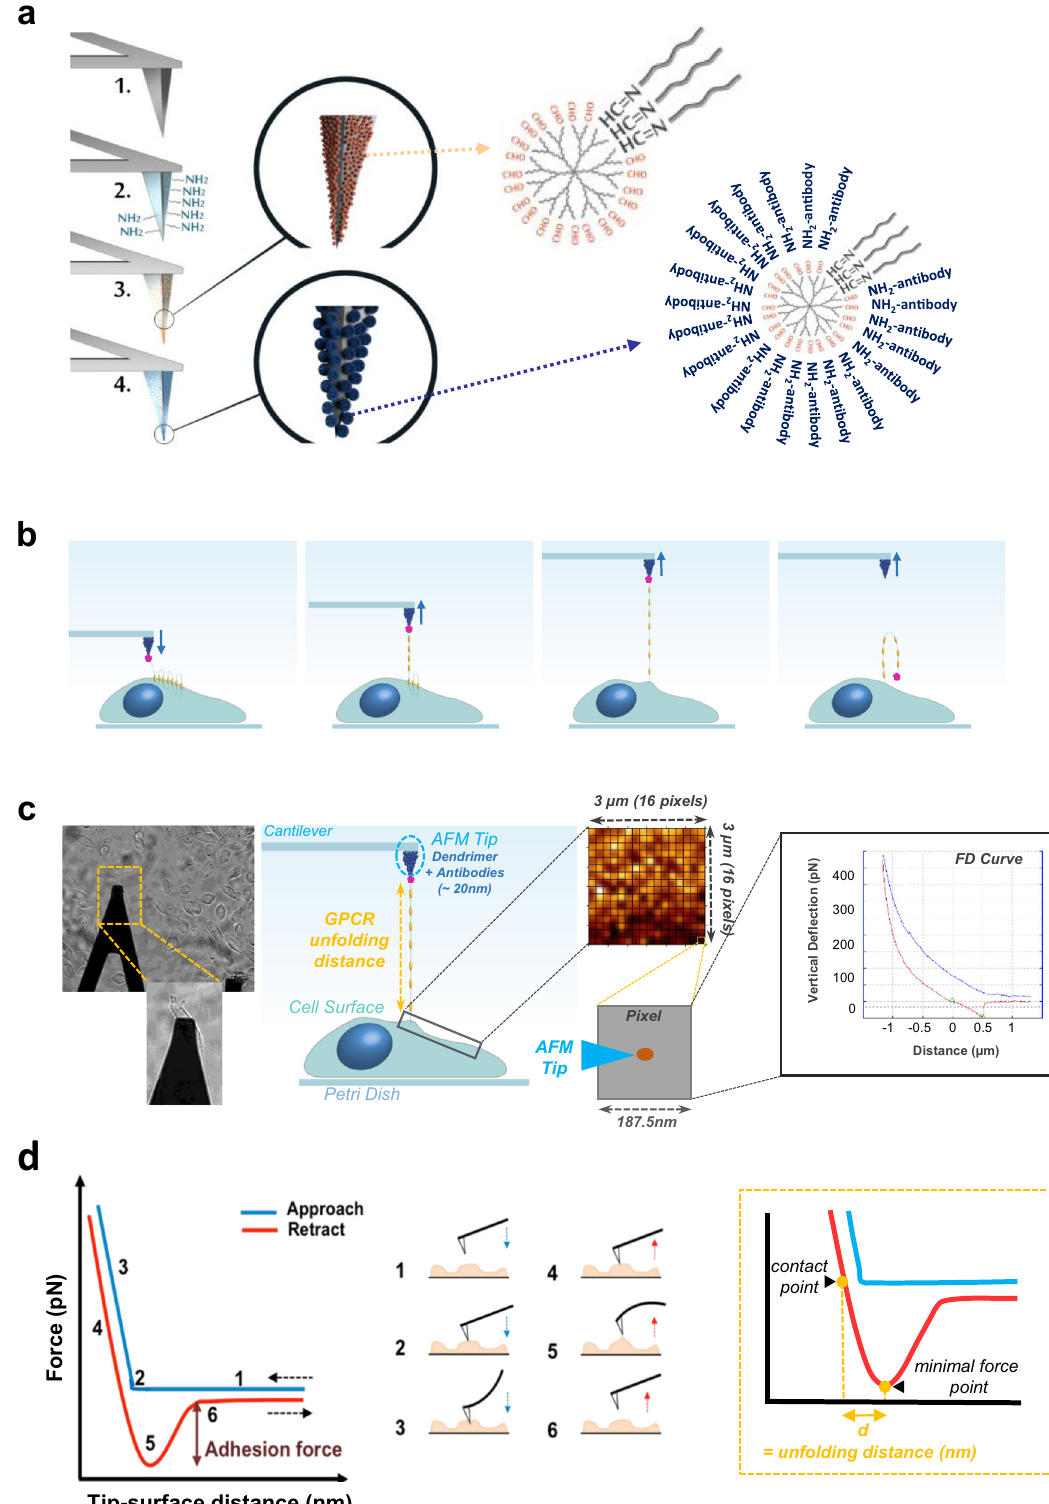
Fig. 1 SMFS-based GPCR unfolding at the living WTT-CHO cell surface. a Schematics of the AFM tip functionalization: (1) the silicon nitride AFM tip, and the sequential addition of (2) amine functions, (3) dendrimers, and (4) anti-HA antibodies. b , c , The functionalized AFM tip is approached to the surface of HA-tagged GPCR-expressing WTT-CHO cells and then retracted until rupture ( b ) on a 3 × 3 µ m 2 area (16 × 16 pixels), resulting in 256 force versus distance curve (FD curve) recordings. d Schematics of a representative FD curve showing the different steps of the AFM tip approach (blue) and retraction (red). The unfolding distance is measured between the contact point and the point of minimal